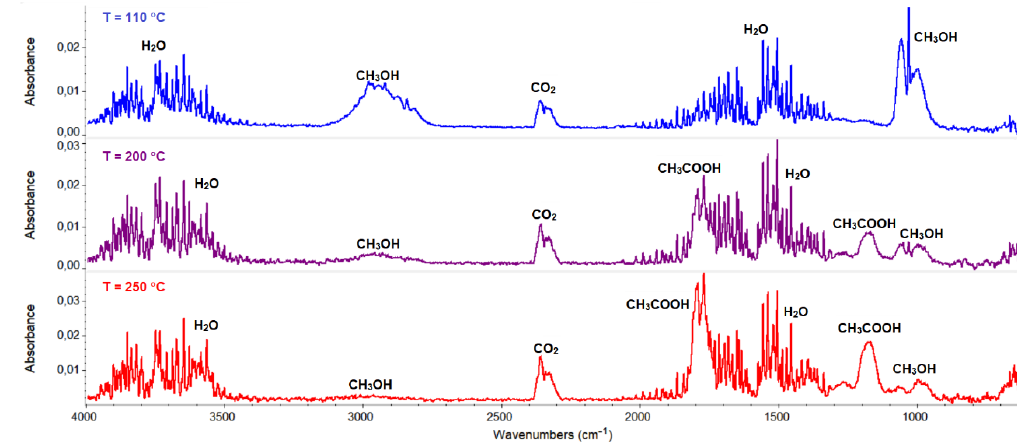
17 of 21 Figure 14. TG, DTG, and DCS curves of thermal decomposition of complex 3 in air. The thermal behavior of complex 3 was also studied in the inert atmosphere of nitrogen. The first stage was similar to that observed in air (i.e., desolvation process). In contrast to the oxidizing atmosphere, a smaller amount of solvent (one and half molecule, found mass loss 4.1%) was released. The remaining methanol molecules were removed from the complex together with the acetate ions,